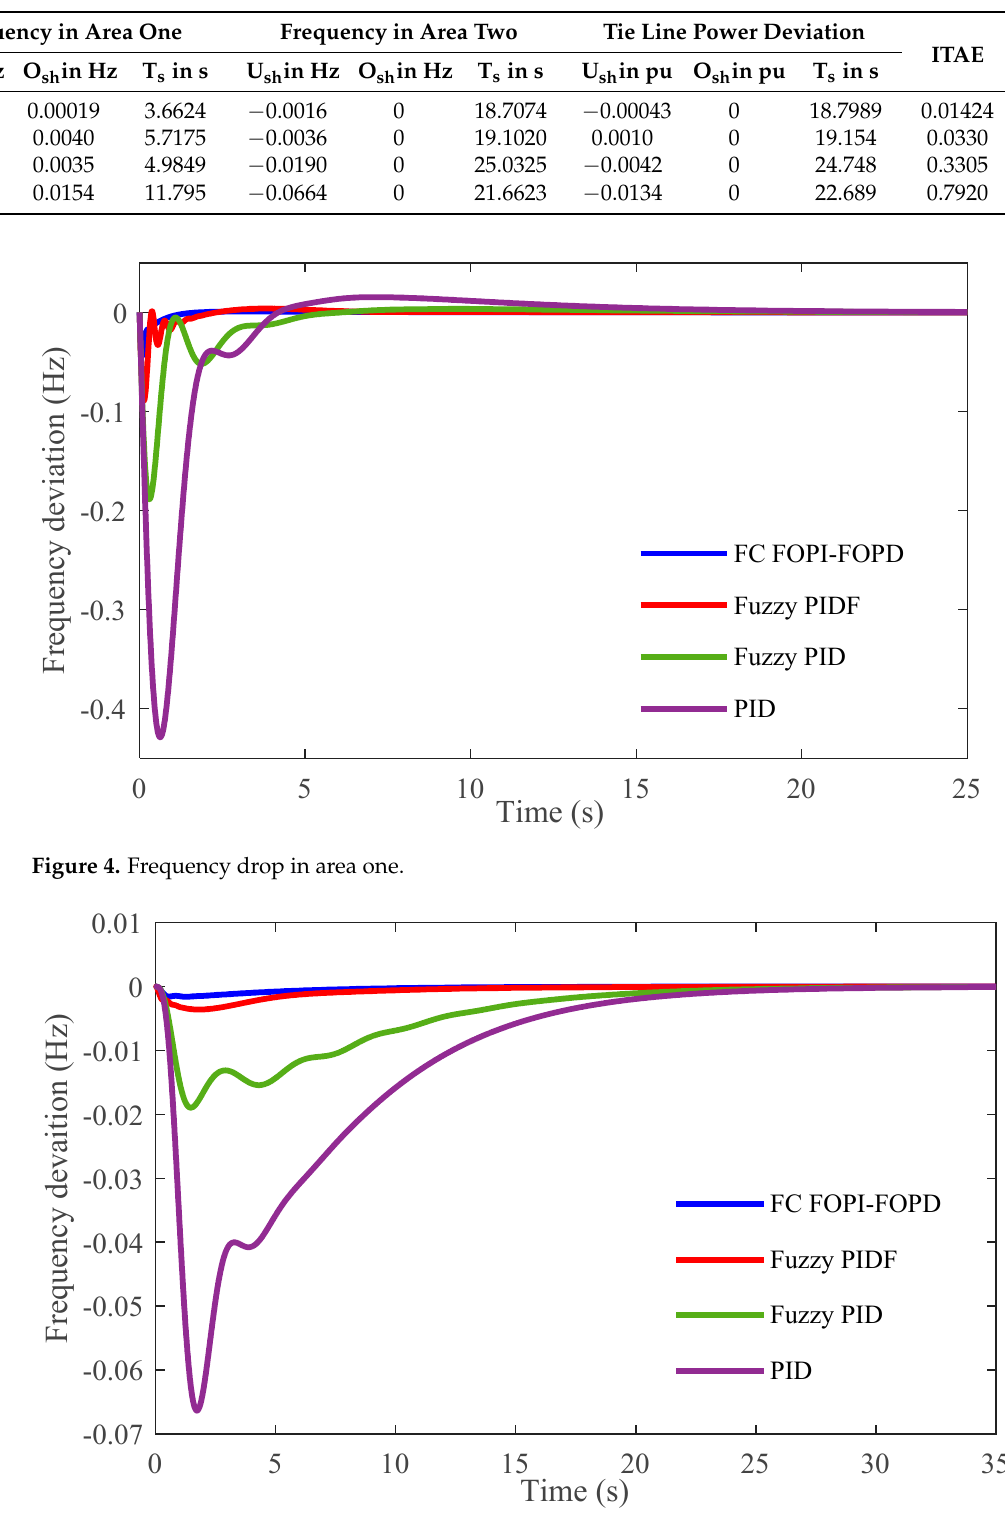
Table 5. The dynamic response of the investigated power system based on different control methods.